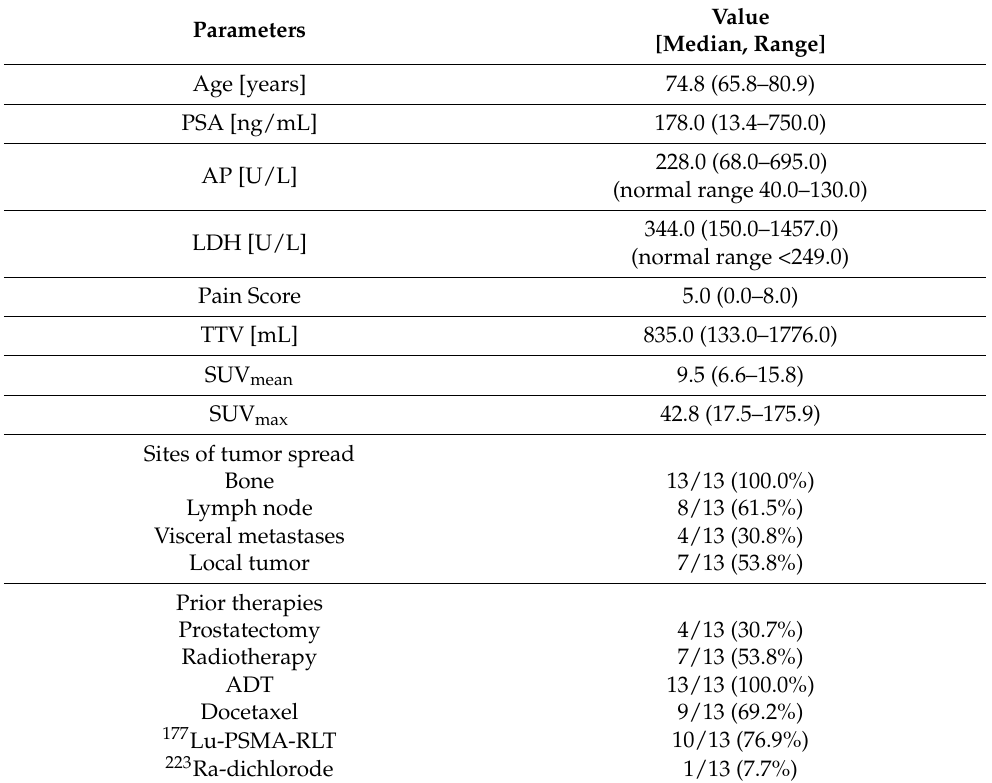
Table 1. Baseline characteristics prior to 225 Ac-PSMA-I&T.